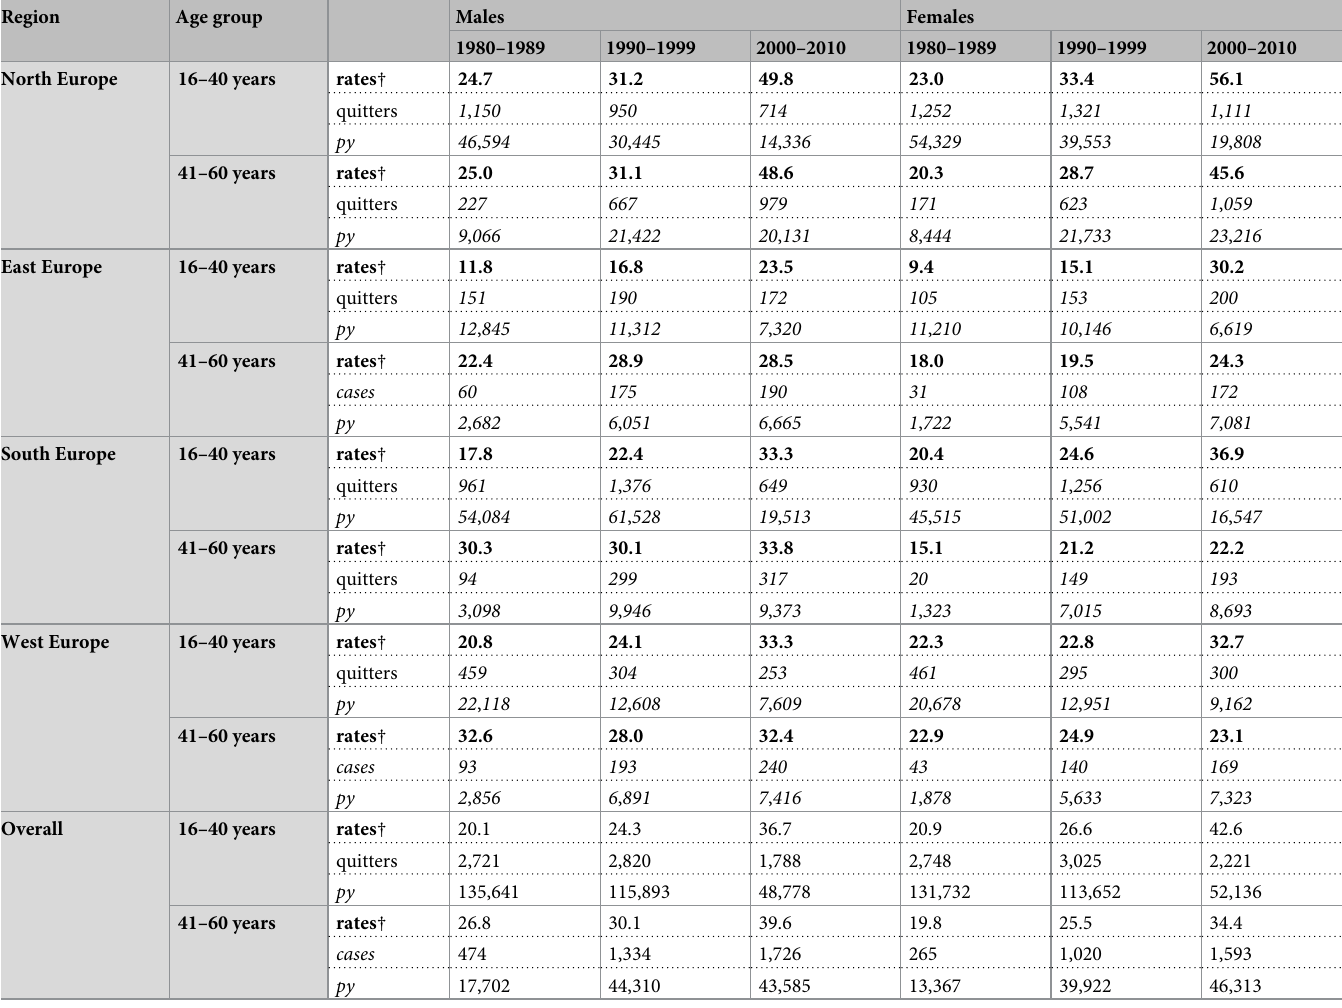
Table 3. Crude rates of smoking cessation (per 1,000/year), number of quitters and person-years at risk in males and females by region, age group and period. Region Age